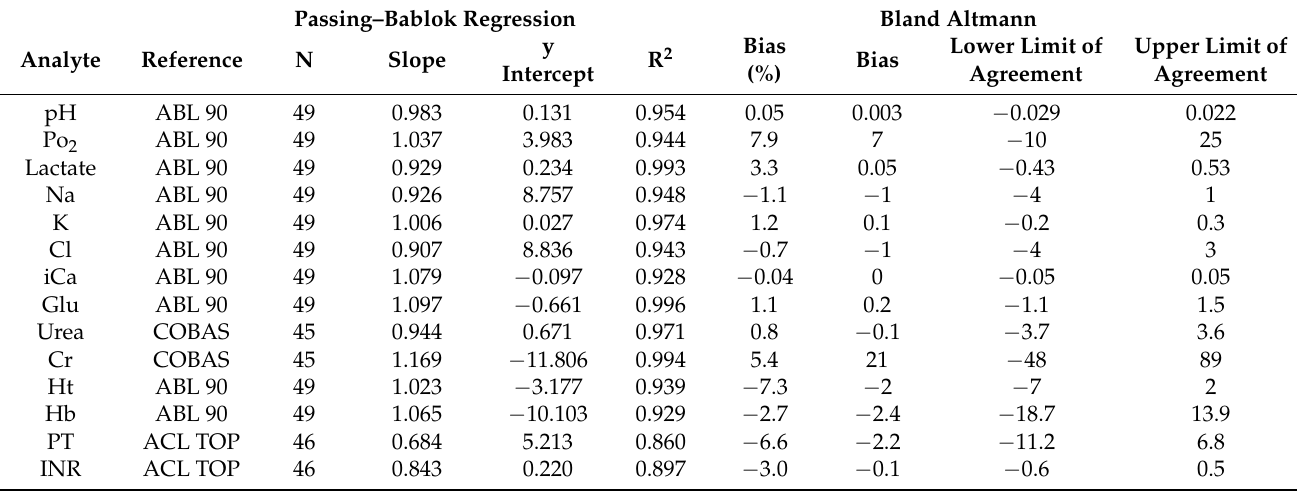
Table 2. Results of the Passing–Bablok regression and Bland–Altman analyses for the iSTAT Alinity measurements compared to the existing laboratory instruments.